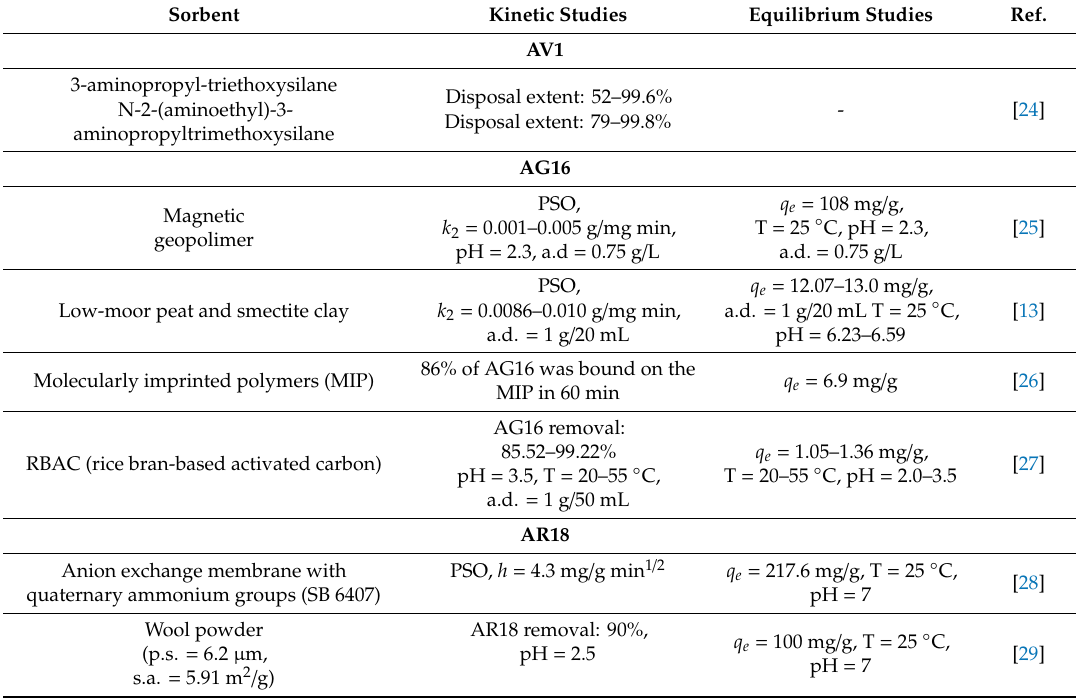
Table 4. The kinetic and equilibrium parameters of AV1, AG16 and AR18 sorption on various adsorbents based on the literature